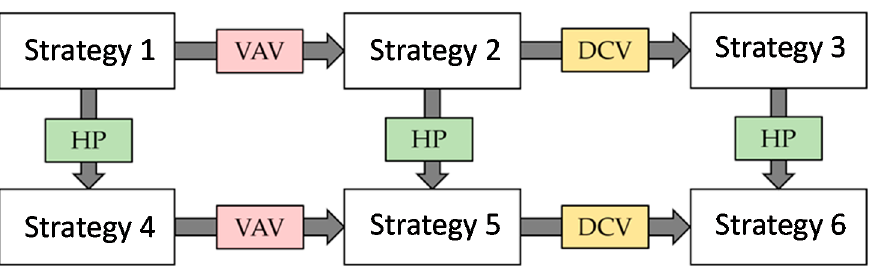
Figure 1. Different configurations and control strategies of HVAC analyzed with boiler (top) and heat pump (bottom) as heating system.